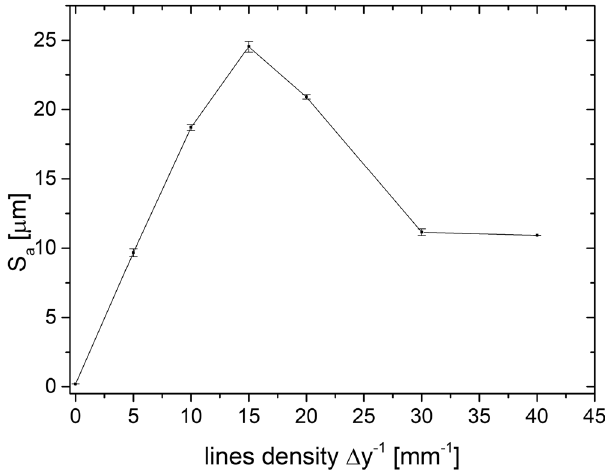
Figure 2. Change in the average surface roughness, S a , as a function of increasing line density ∆ y − 1 on a laser- textured AISI 316 L surface.